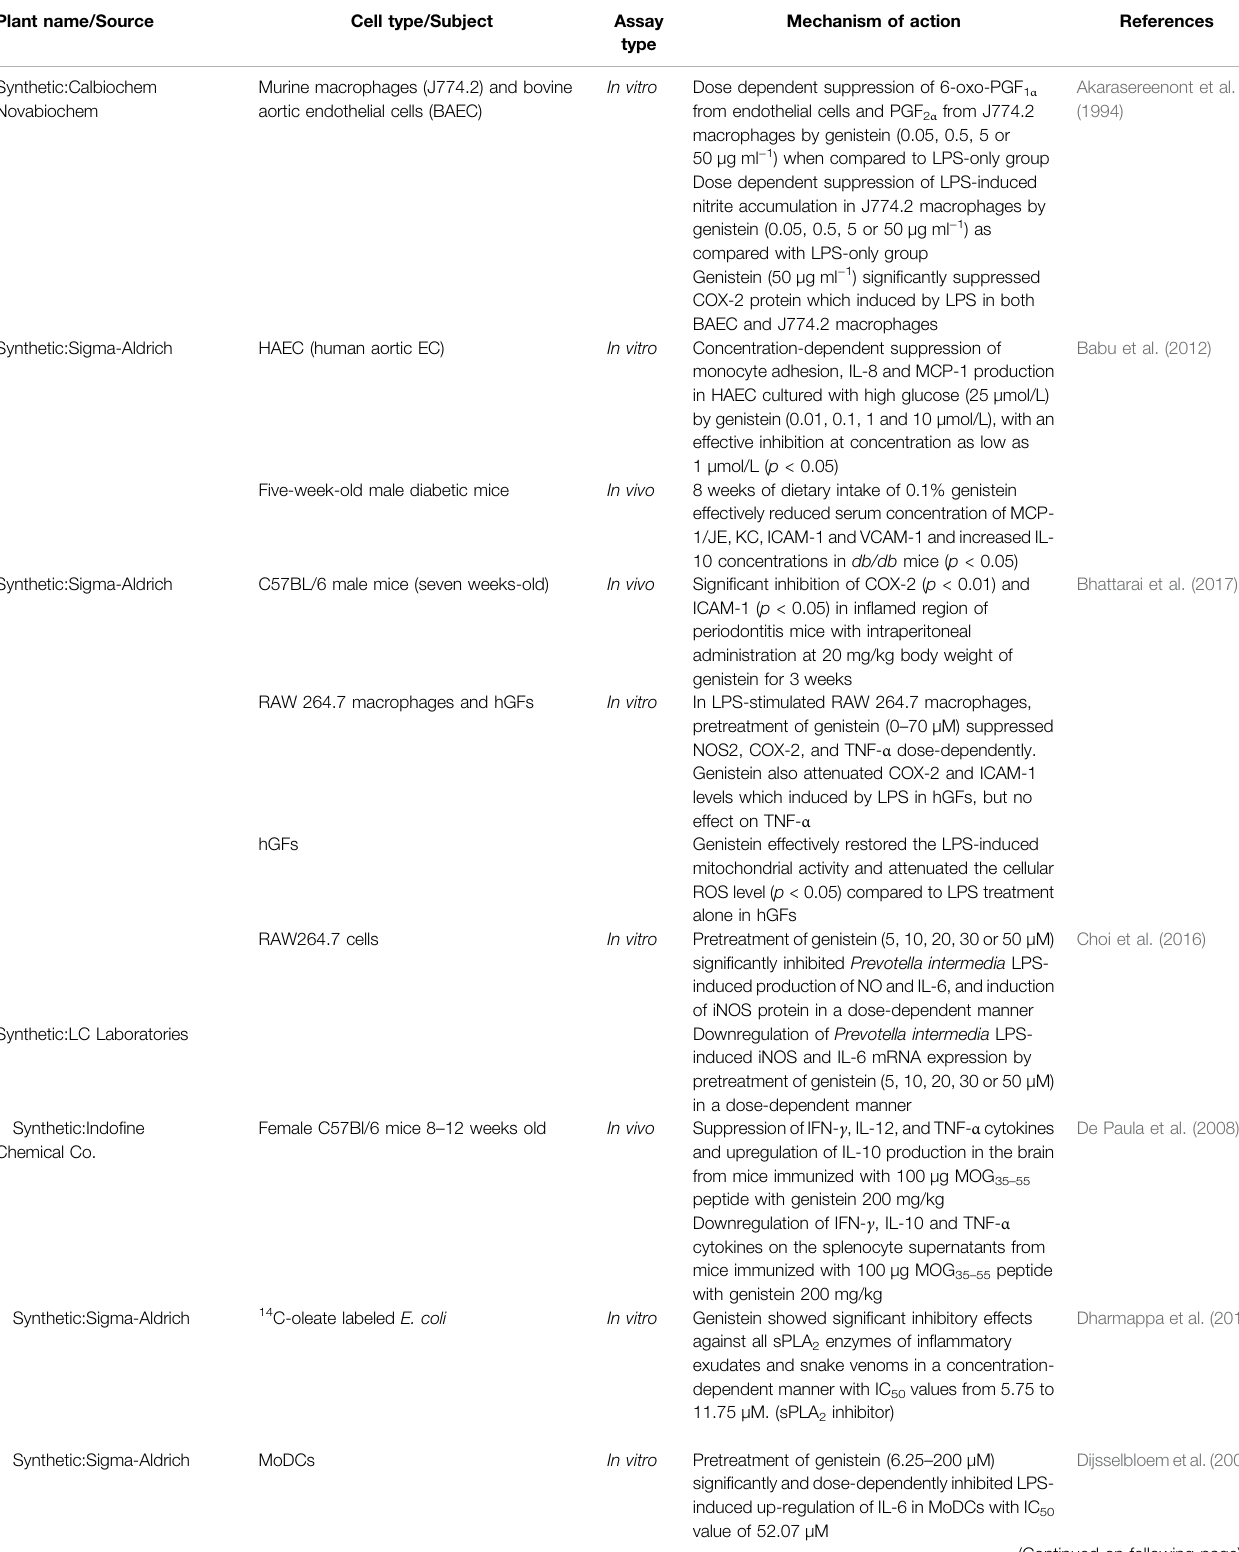
TABLE 1 | Genistein with potent anti-in fl ammatory